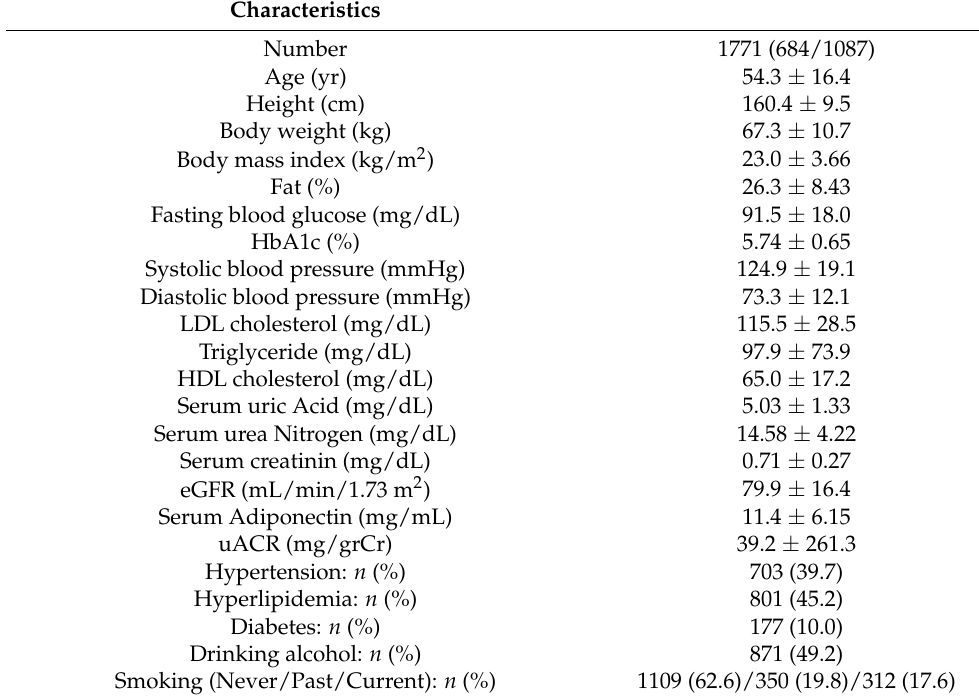
Table 1. Clinical characteristics of the